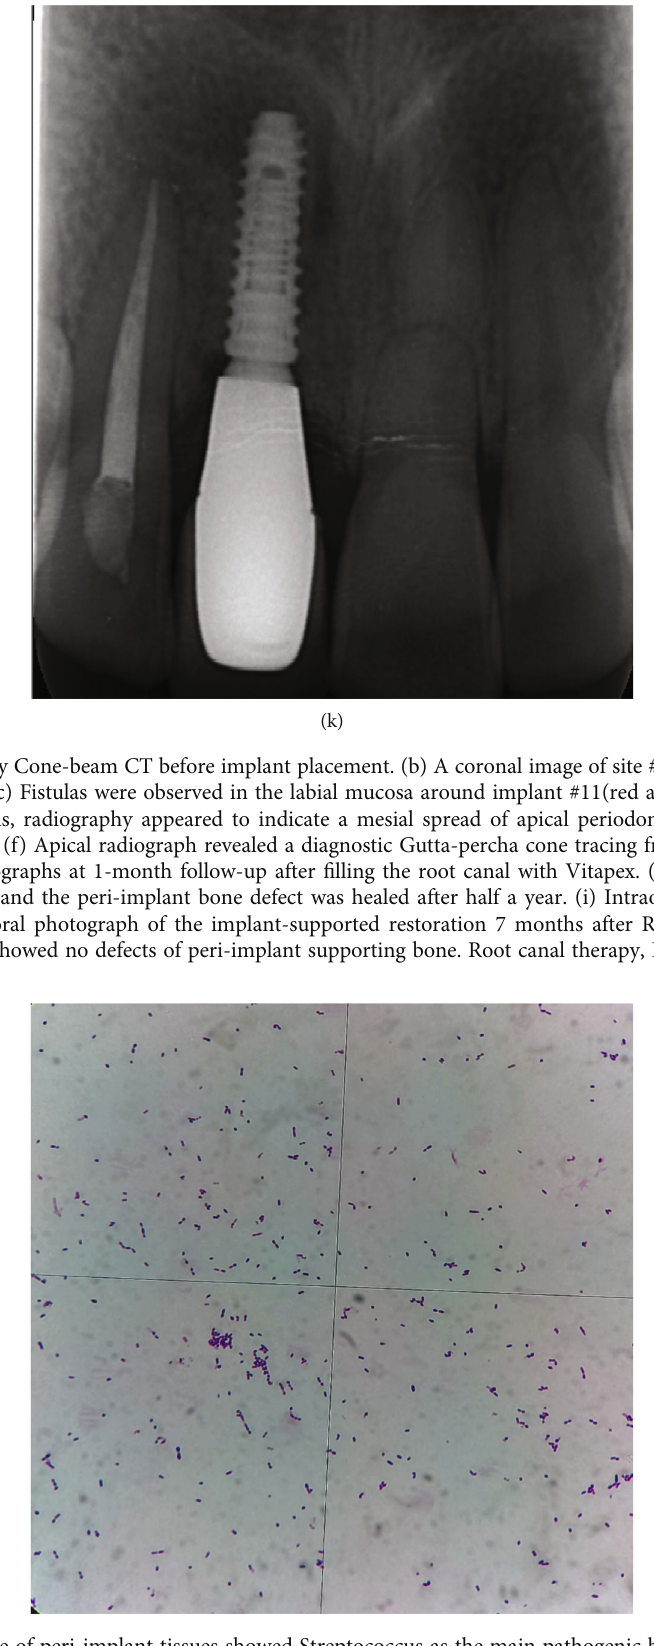
Figure 4: The bacterial culture of peri-implant tissues showed Streptococcus as the main pathogenic bacteria. (Gram staining, ×